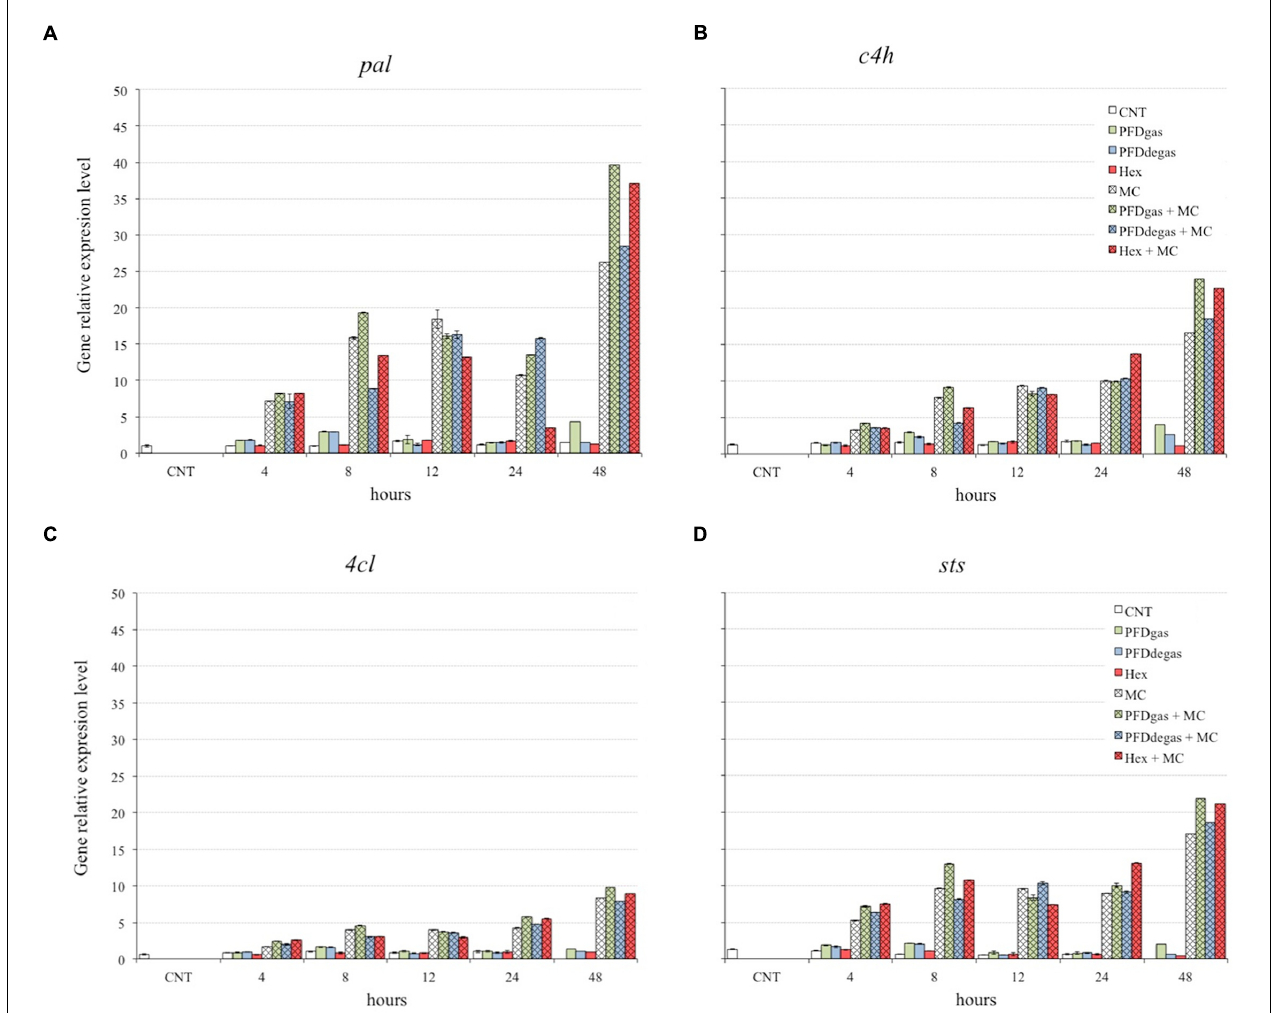
FIGURE 6 | Relative expression level of genes pal (A) , c4h (B) , 4cl (C) , and sts (D) in V. vinifera cell cultures elicited at 48 h of culture. CNT: culture medium control; PDFgas, gassed perfluorodecalins; PFDdegas, degassed perfluorodecalins; PDFgas + MC, gassed perfluorodecalins plus MeJA and β -CDs; PDFdegas + MC, degassed perfluorodecalins plus MeJA and β -CDs; Hex, Hexenol; Hex + MC, Hexenol + MeJA+ β -CDs; MC, MeJA and β -CDs. Data are the mean of three independent replicates ±